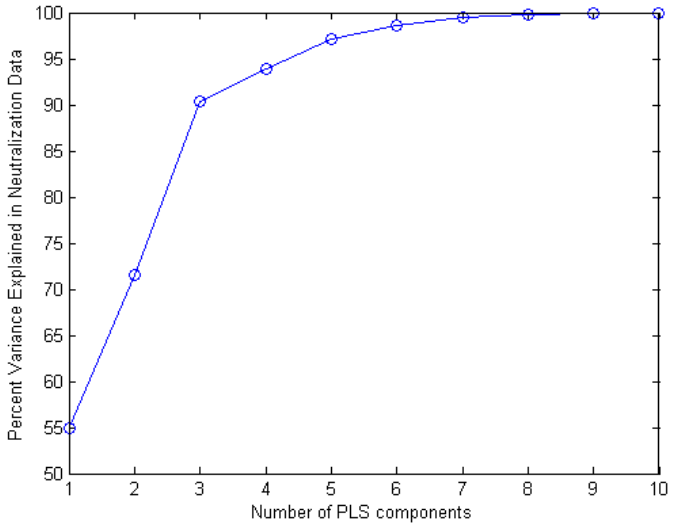
Figure 4. Percent of variance explained in the response variable as a function of the number of Partial Least Squares (PLS) components.